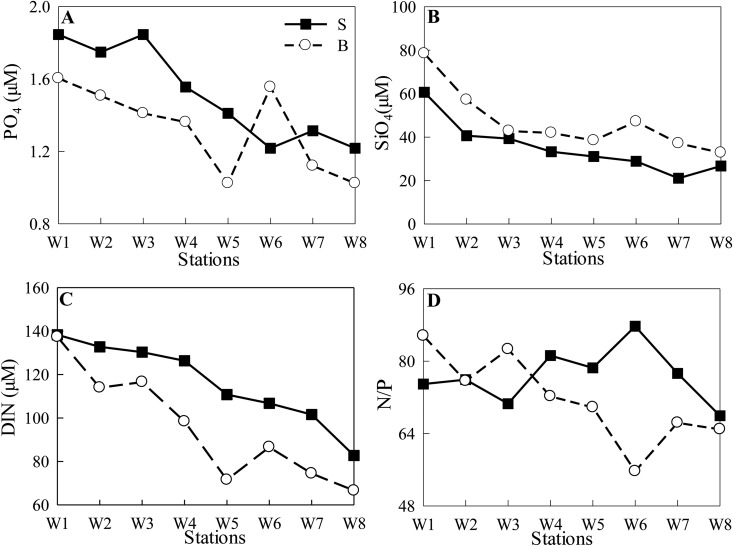
Nutrients concentrations (A: PO4, B: SiO4, C: DIN) and N/P ratios (D) of the transect during ST.